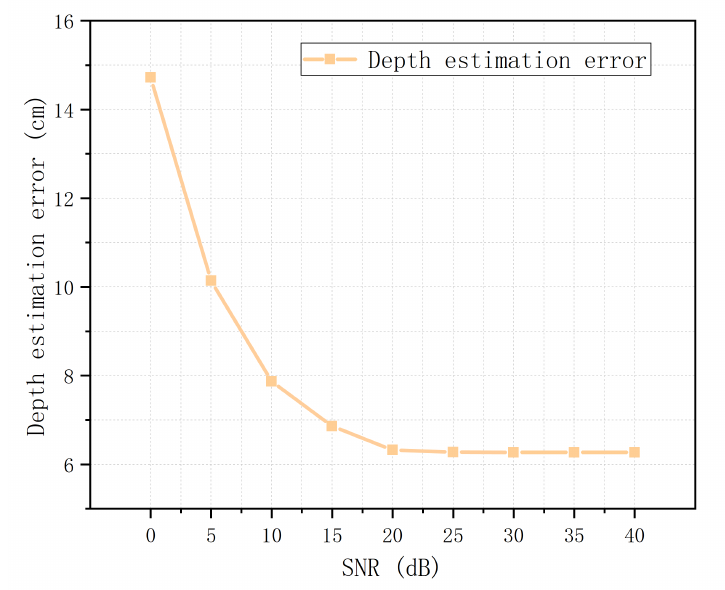
Figure 9. Cylindrical target depth estimation error at different SNR values.